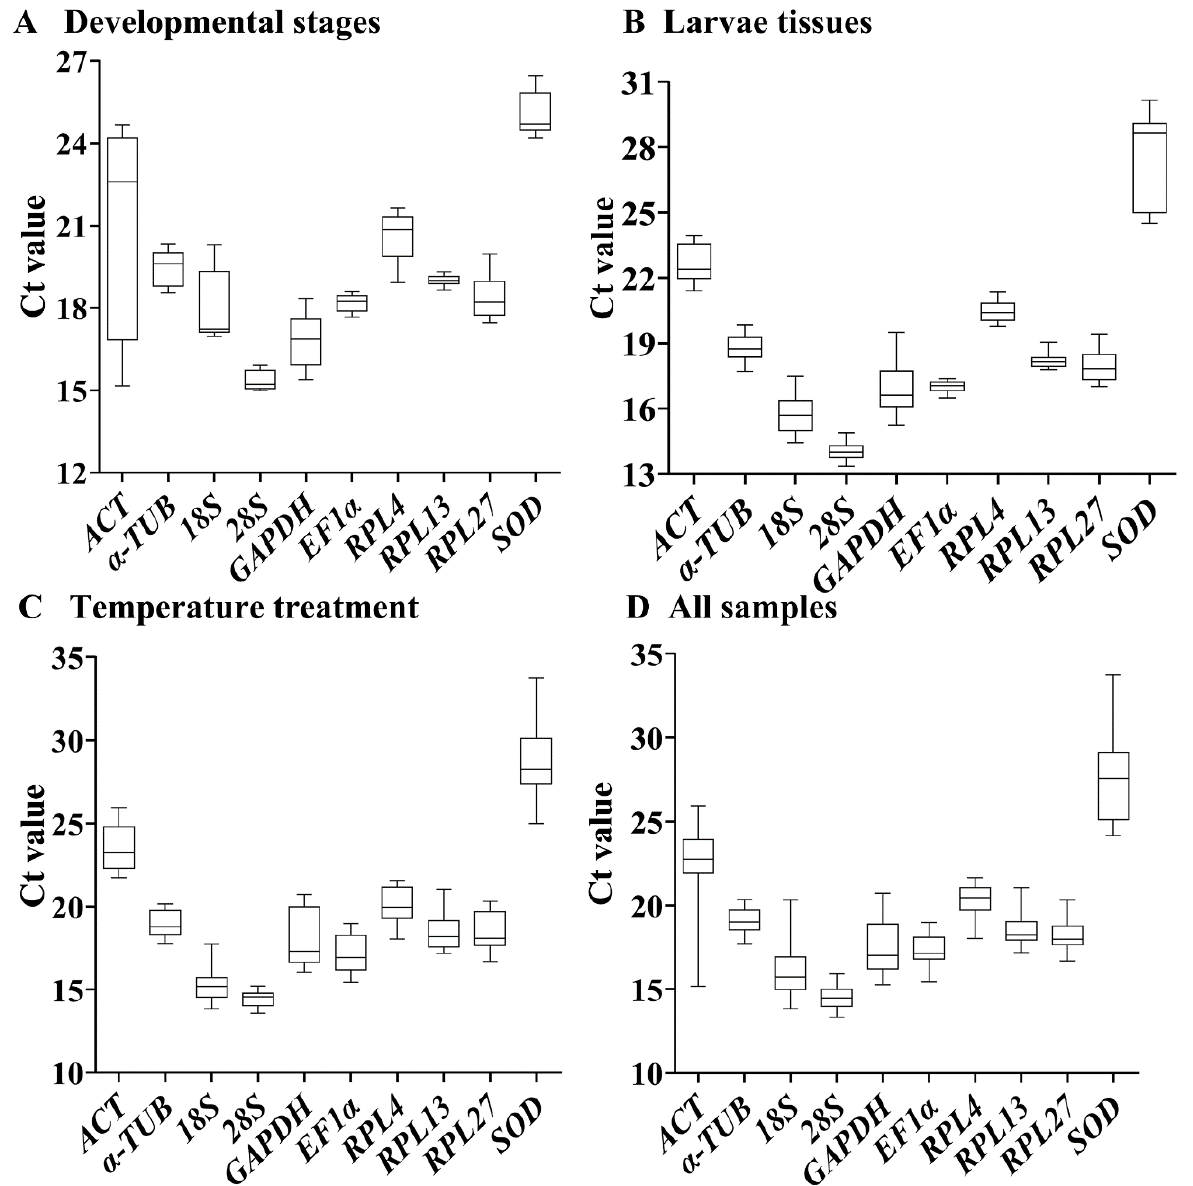
Figure 1. Expression levels of ten house-keeping genes in Phthorimaea operculella . The mean Ct values for 10 candidate reference genes are shown in three independent experiments: developmental stage, tissue, and temperature. Each box indicates the 25th and 75th percentiles. The line across the box represents the median. Abbreviation: ACT, actin; α -TUB, α -tubulin; GAPDH, glyceraldehyde-3- phosphate dehydrogenase; EF1 α , elongation factor 1 α ; 18S and 28S, 18S and 28S ribosomal RNA; RPL4, RPL13 and RPL27, ribosomal protein; SOD, superoxide dismutase. The abbreviations are exactly the same as Figures 2–5.